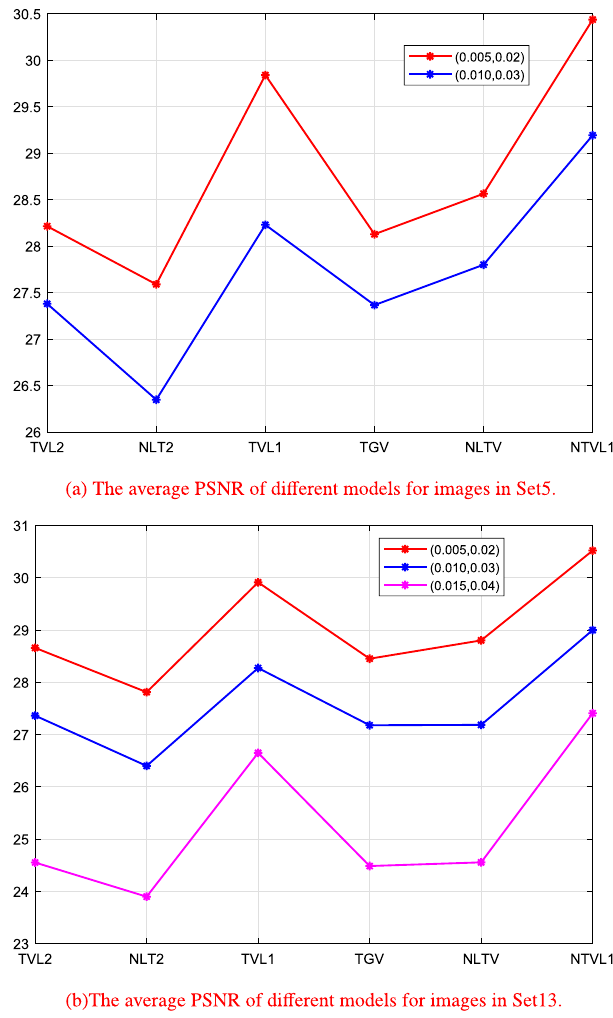
Figure 14. The plots of the relative-change of the restorations versus